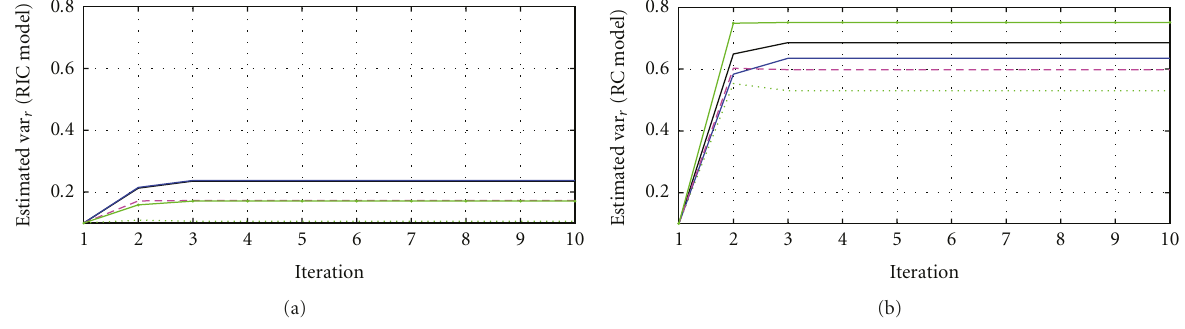
Figure 5: Estimated measurement noise variance produced by representative healthy patient (a) for RIC model and (b) for nonlinear RC